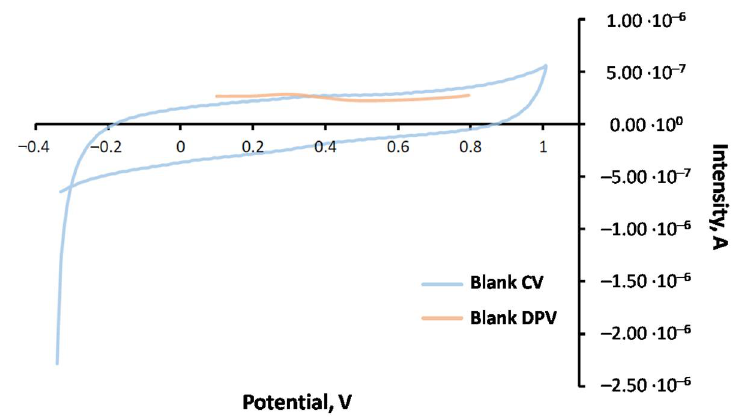
Figure 4. CV and DPV voltammograms for blank samples.